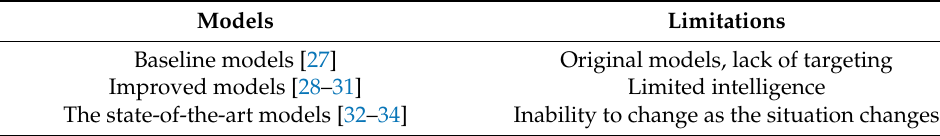
Table 1. The overview of related